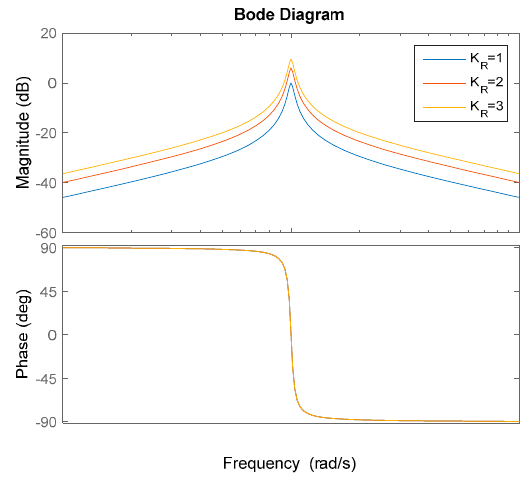
ff erent values K R when w c is